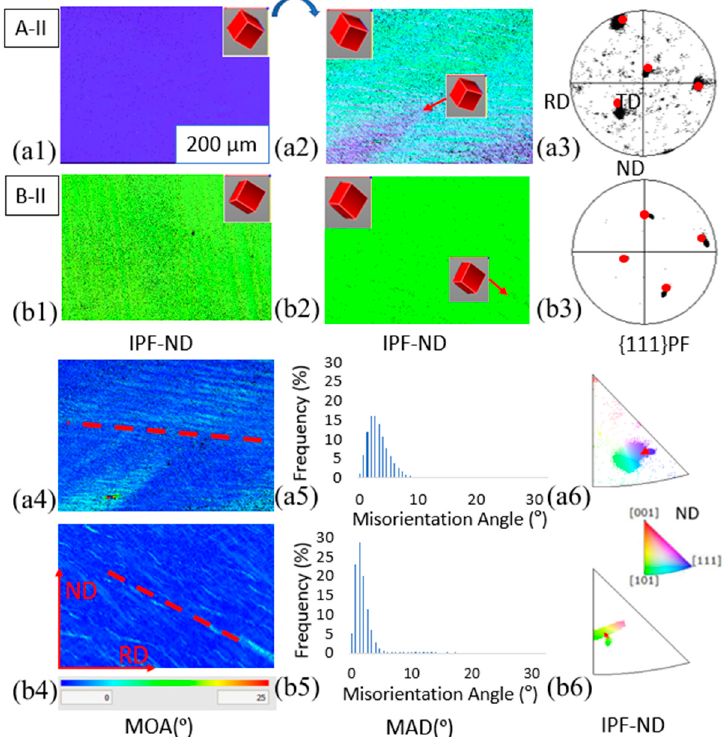
Figure 8. ( a1 – a6 ) and ( b1 – b6 ) are the EBSD results for A-II and B-II, respectively. ( a1 – a2 ) and ( b1 – b2 ) are the EBSD IPF-ND maps for samples before and after the PSC. ( a3 ) and ( b3 ) are the {111} PF for crystals after deformation with red dots represents the orientation for the undeformed samples. ( a4 ) and ( b4 ) are MOA maps of deformed crystals. Red dashed lines represent the alignment of the most apparent DBs set. ( a5 ) and ( b5 ) represent the MAD for crystals after deformation. ( a6 ) and ( b6 ) are the IPF-ND of the undeformed and deformed crystals plotting together, with the arrow indicates the rotation around the loading direction.